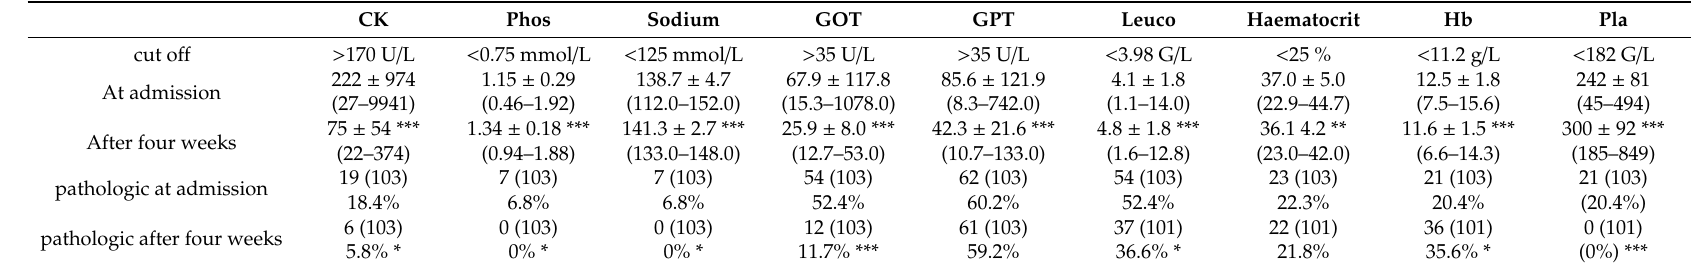
Table 2. Laboratory values at admission (T1) and after four weeks (T5), Mean and SD for 103